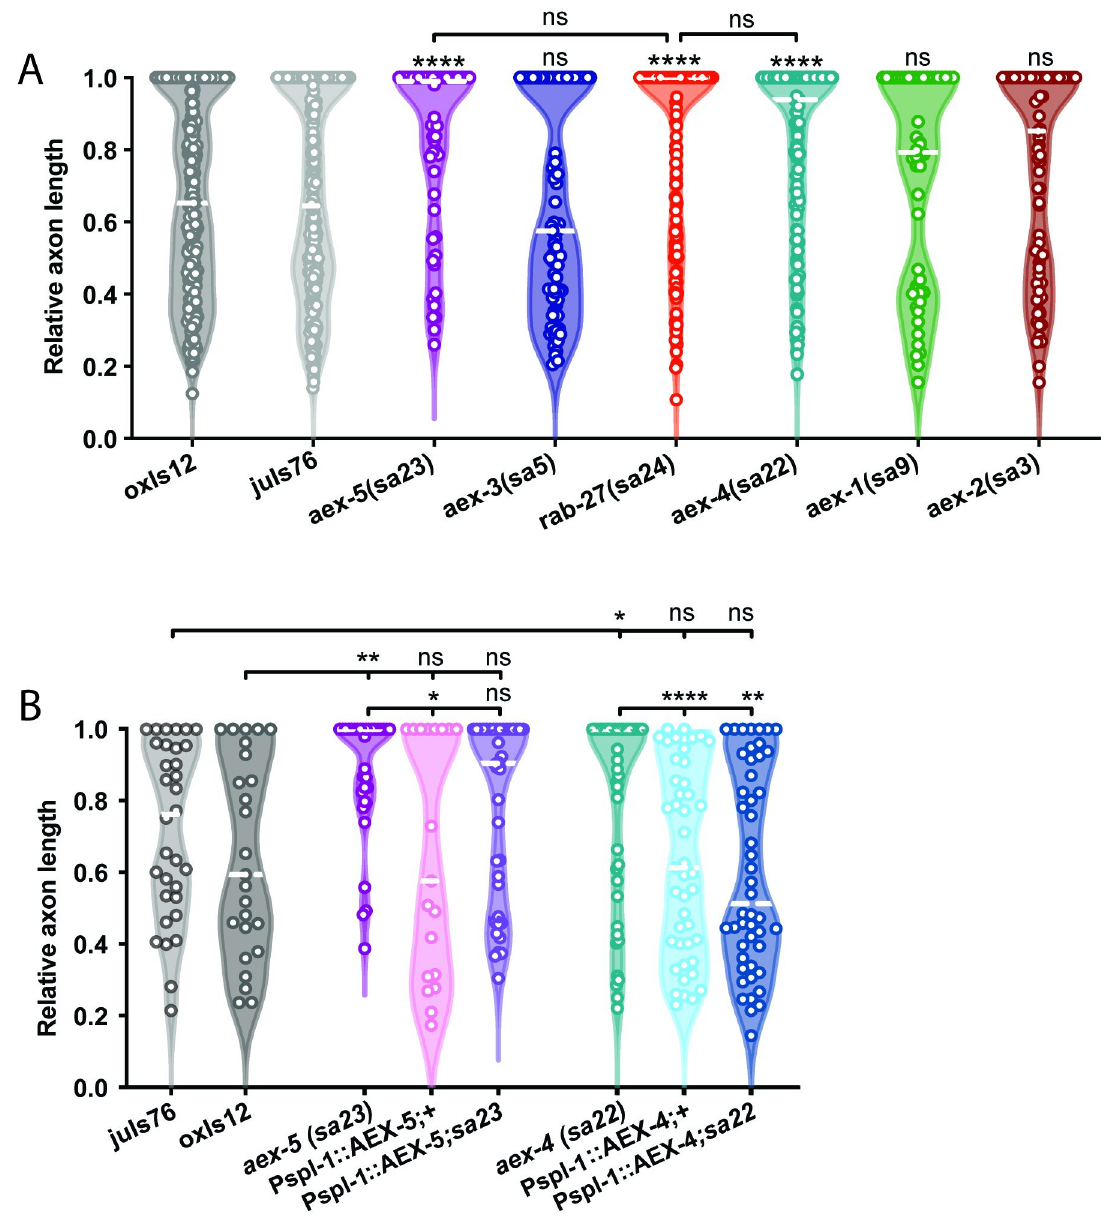
Fig 3. AEX-4 and AEX-5 inhibit axon regeneration. (A) Relative axon length in control animals expressing GABAergic neuron-specific GFP ( oxIs12 & juIs76 ), and aex-1 (sa9), aex-2 ( sa3 ), aex-3 ( sa5 ), aex-4 ( sa22 ), aex-5 ( sa23 ) and rab-27 ( sa24 ) mutants. aex-1 , aex-5 , and rab- 27 are compared against oxIs12 , while aex-2 , aex-3 , while aex-4 are compared against juIs76 . Axons cut per genotype, L to R: 238, 199, 37, 83, 148, 69, 50, 66. Kolmogorov-Smirnov test was used. ns, not significant, � p < 0.05, �� p < 0.005 ���� p < 0.0001. (B) Relative axon length in control animals expressing GABAergic neuron-specific GFP ( oxIs12 & juIs76 ), aex-5(sa23) and aex-4(sa22) mutant animals, and animals expressing AEX-5 and AEX-4 cDNA under an intestine-specific promoter ( Pspl-1 ) and stabilized with rab-3 3’ UTR sequence, in both control and respective mutant backgrounds. Axons cut per genotype, L to R: 32, 25, 19, 45, 46, 48, 33, 38. Kolmogorov- Smirnov test was used. ns, not significant, � p < 0.05, �� p < 0.005 ���� p <